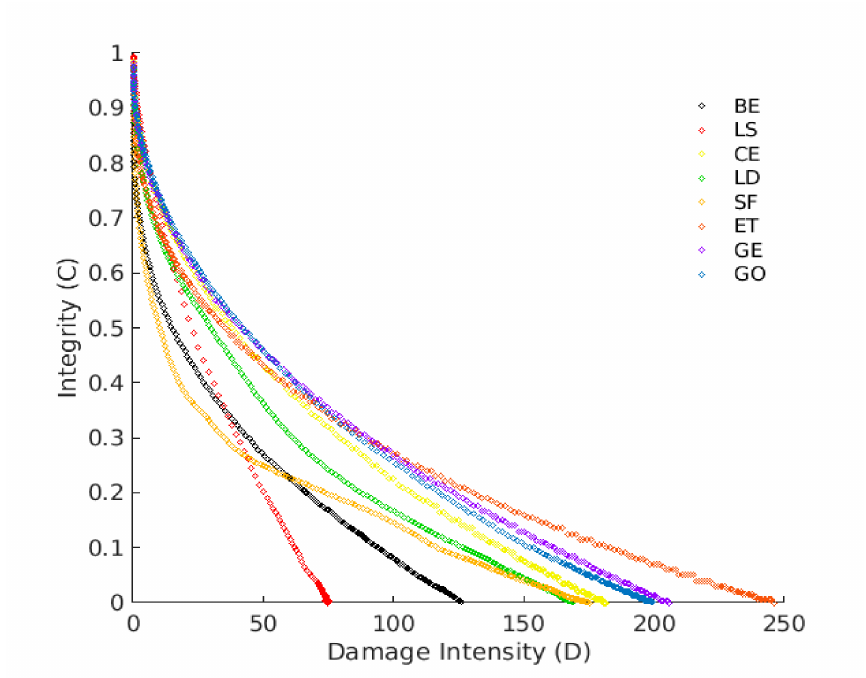
Figure 13. Viscoelastic Continuum Damage (VECD) curve from amplitude